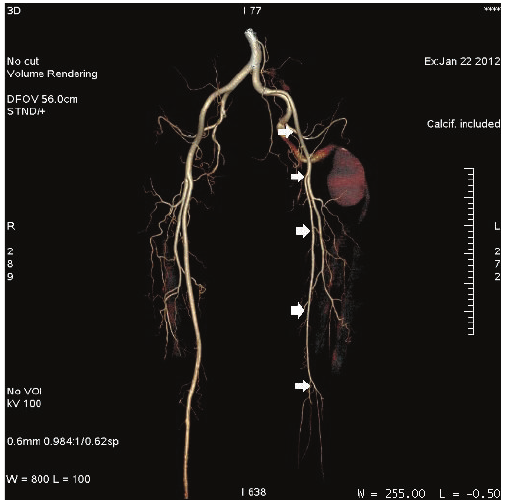
Figure 4: CT angiogram. The arrows depict the course of the external iliac artery and the superficial femoral system. Note that the femoral vessel is hypoplastic compared with the normal opposite limb and ends in the